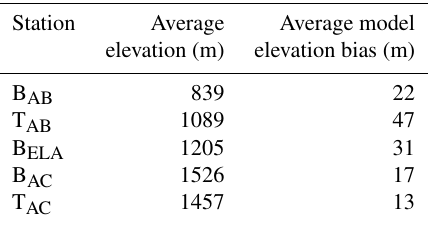
Table 1. Average measured elevation and average bias of the inter- polated HIRHAM5 elevation at each station for 2001–2014.